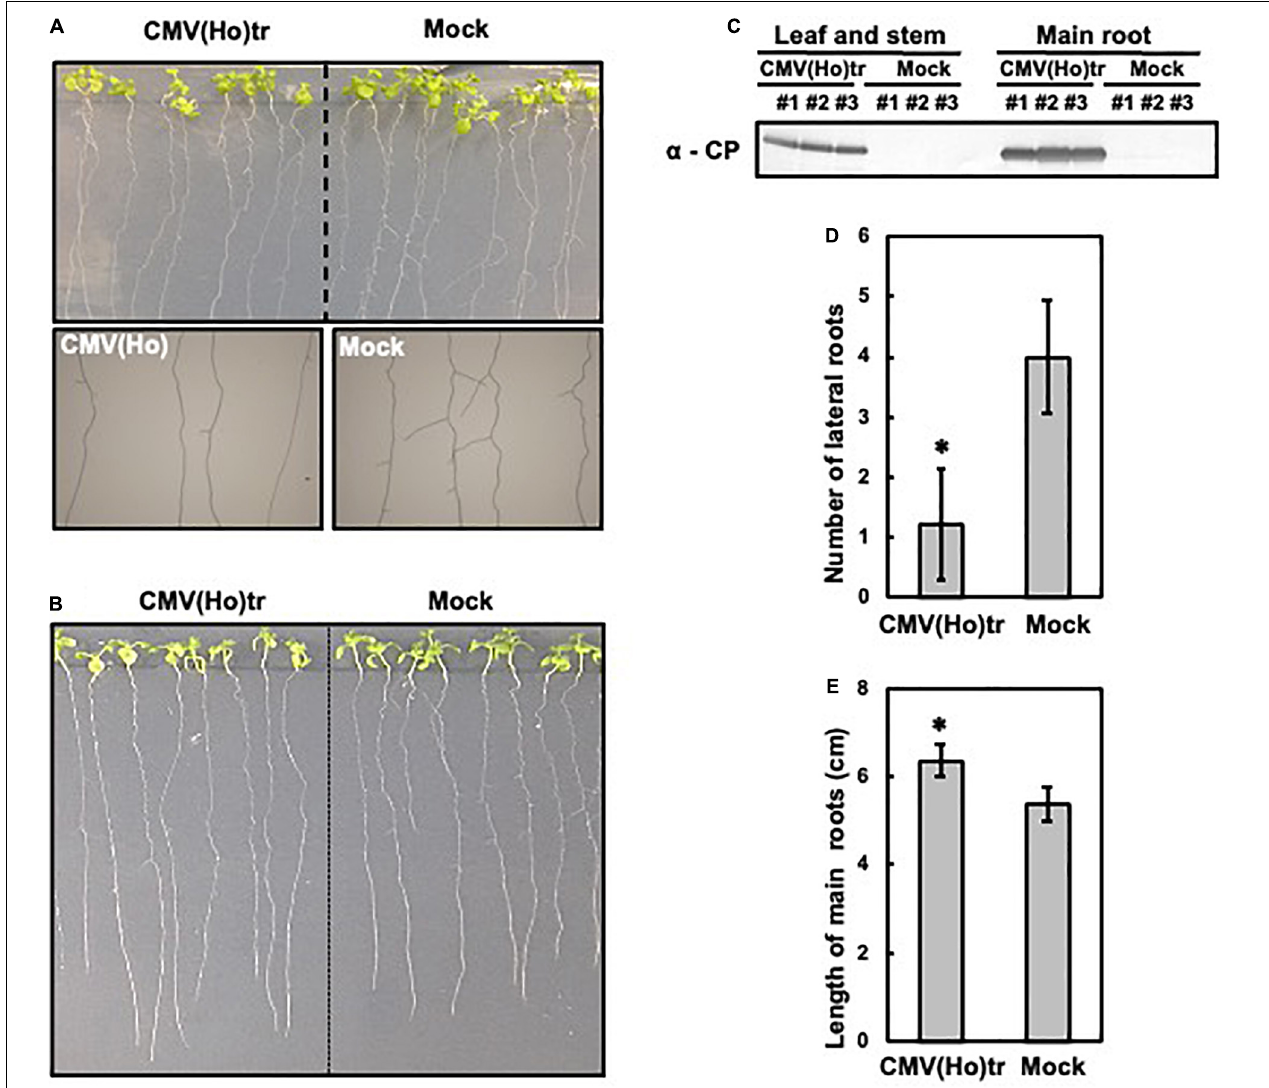
FIGURE 5 | The influence of infection with CMV(Ho)tr on root growth of A. thaliana ecotype Col-0. Fully expanded leaves of Col-0 plants at 7 days after sowing on 1/2 Murashige–Skoog medium were inoculated with CMV(Ho)tr or sodium phosphate buffer (pH 7.0) (mock) as a control. Photographs of the development of lateral roots of CMV(Ho)tr- and mock-inoculated plants are shown in upper side in (A) , and enlarged photographs of the lateral roots are shown in the lower side in (A) . Photographs of the development of main root of CMV(Ho)tr- and mock-inoculated plants are shown (B) . Systemic infection with CMV(Ho)tr was confirmed by immunological detection of the coat protein in root tissue (C) . The number of lateral roots (D) and length of the main root (E) of independent CMV(Ho)tr- or mock-inoculated plants at 7 dpi are shown in the bar chart with error bars ( n = 10, SD). An asterisk denotes the significant difference between CMV(Ho) and mock control plants (Welch’s t -test, p <